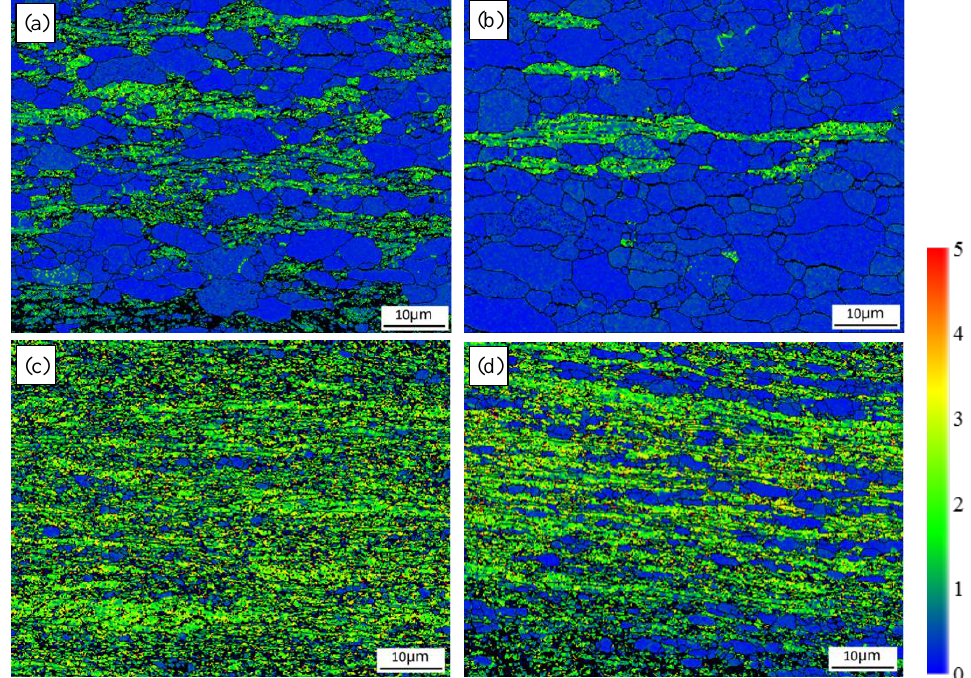
Figure 3. Misorientation map of Ti and Ti-V steel with different annealing processes at 690 °C, Ti steel: ( a ) 100 s, ( b ) 1000 s; Ti-V steel: ( c ) 200 s and ( d ) 1000 s.